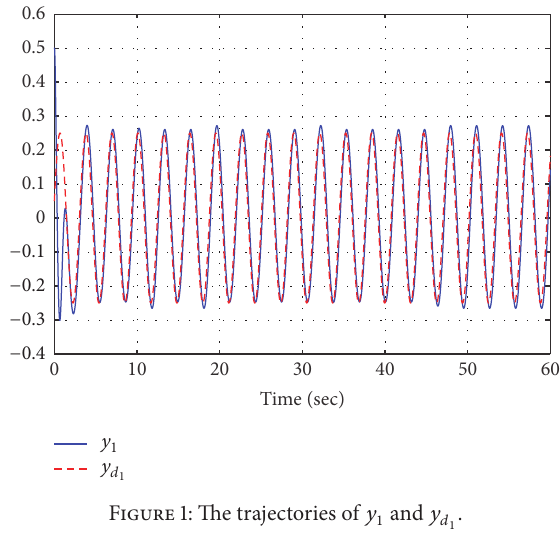
Figure 1: The trajectories of 𝑦 1 and 𝑦 𝑑